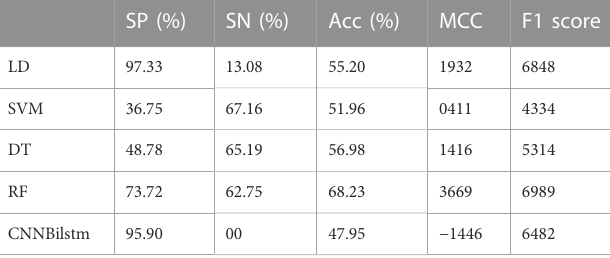
TABLE 4 The performances of DPC